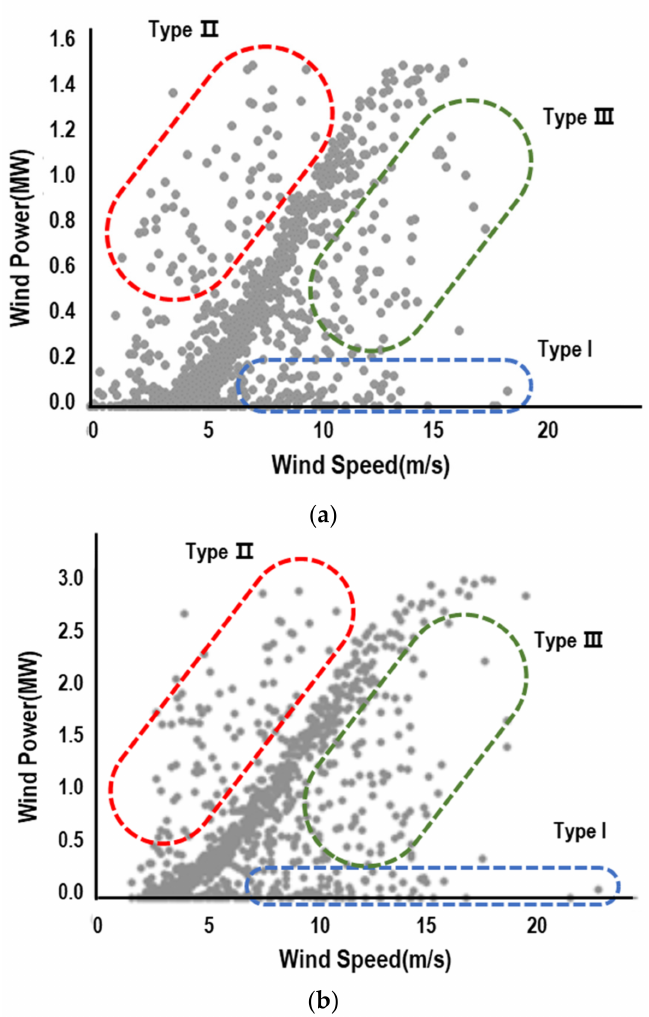
Figure 2. Observations of Power Output against Wind Speed. ( a ) 1.5 MW Wind Turbine; ( b ) 3.0 MW Wind